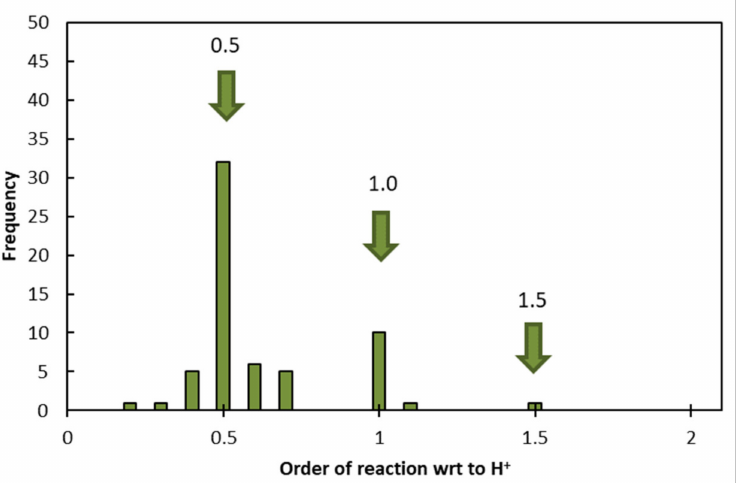
Figure 4. The frequency of orders of reaction with respect to H + for 62 values of the dissolution of 50 different minerals. Data given in Tables 1–4. (Note: wrt means ‘with respect